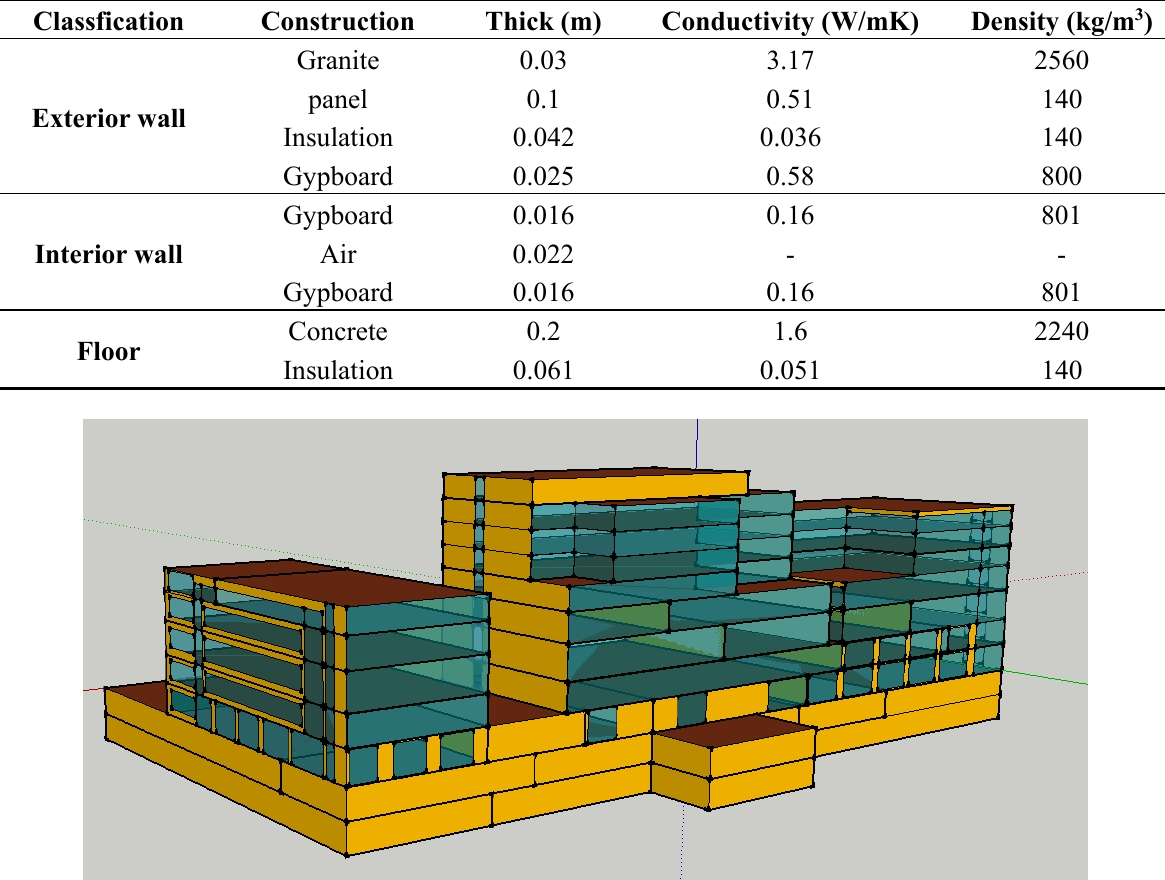
Figure 8. Building modeling using the sketch up